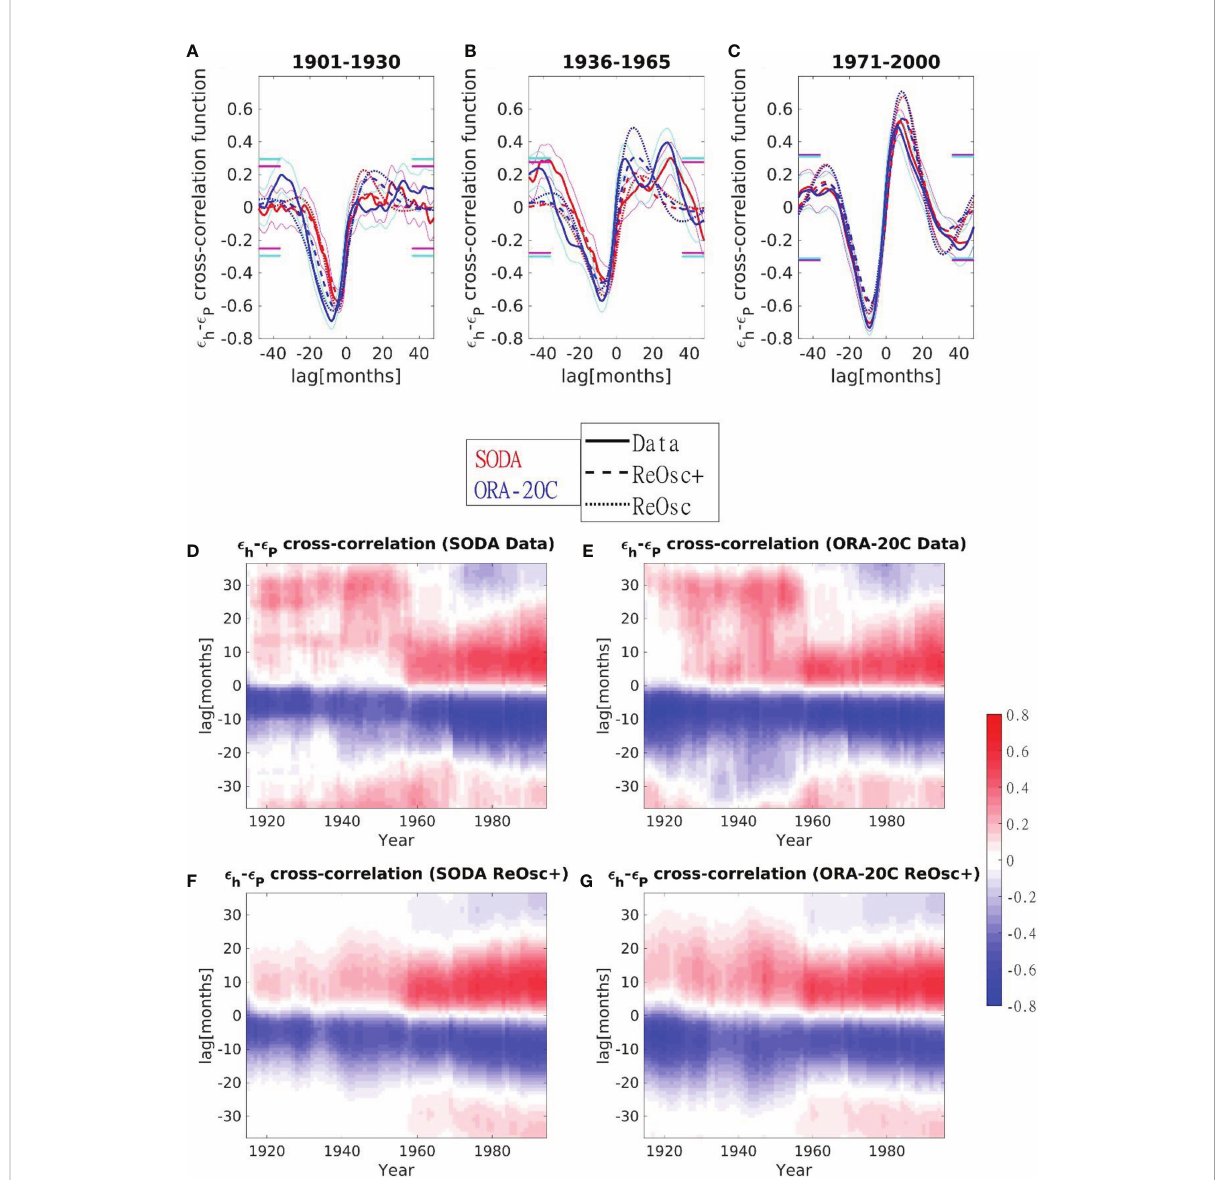
FIGURE 2 Normalized cross-correlation functions. c N hP , between the Paci fi c thermocline depth and the Paci fi c SST anomalies for the periods 1901-1930 (A) , 1936- 1965 (B) , and 1971-2000 (C) , SODA (solid red line) and ORA-20C (solid blue line, mean of all members) data, ReOsc+ model (dashed line) and ReOsc model (dotted line) for the two-variable Paci fi c-Atlantic dynamics (Eq. 7 fi tted as explained in Section 2.3). Magenta (for SODA) and cyan (for ORA-20C) thin lines show the 95% con fi dence interval of the data crosscorrelation (see Supplementary Appendixes A, D). Magenta (for SODA) and cyan (mean of all members for ORA-20C) thick lines show the uncertainty in uncorrelation beyond 36 months, i.e., solid lines inside those limits indicate that there are no signi fi cant contributions from the correlations beyond 36 months (see Supplementary Appendix B). ( D – G ) Color map of the normalized cross- correlation function for SODA (period 1900-2008) and ORA-20C (period 1900-2009, mean of all members) reanalysis, both for the data ( D , E , respectively) and for the ReOsc+ model ( F , G , respectively). Each column represents the function for a time window of 30 years, and the represented year in the horizontal axis is the mean value of that interval. The vertical axis indicates the lag in the cross-correlation function (if positive, h leads). Red Blue Colormap (Auton, 2022) was used in Panels ( D – G ) of this fi